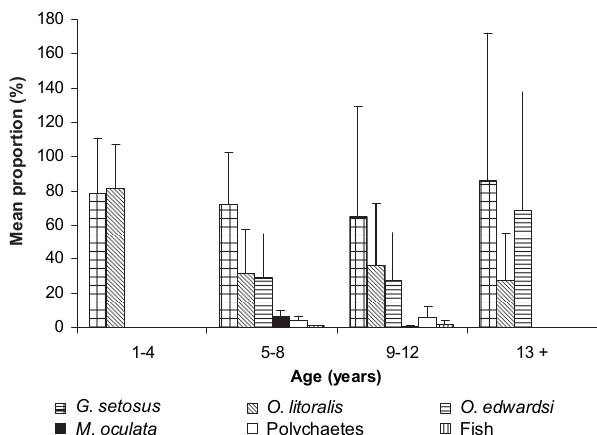
Fig. 1. – Mean and standard deviation of the proportion (%) of amphipod diet items ( Gammarus setosus , Onisimus litoralis and O . edwardsi ) and diet items with high δ 15 N signatures ( Mysis ocu- lata , polychaetes and fish) among age classes of shorthorn sculpin from Peterhead Inlet and the Sylvia Grinnell River estuary, Nunavut. Note absence of fish in the diet is likely due to the small sample size (n = 6) of sculpin > 13 + years.